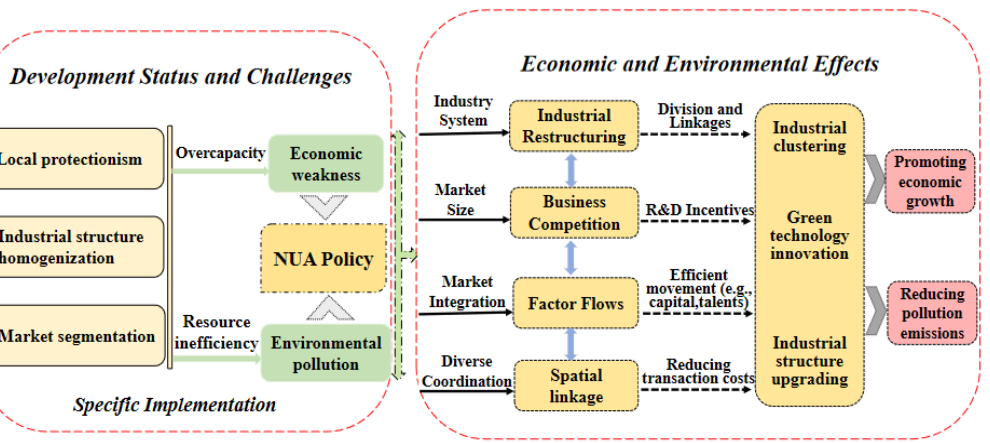
Figure 1. Mechanistic transmission diagram of the NUA policy and economic growth and environ- mental pollution.